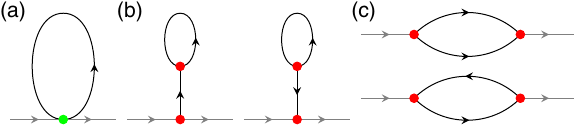
FIG. 3. Feynman diagrams contributing to 1 =S many-body corrections in anharmonic spin-wave theory. (a) Hartree diagram with the number-conserving four-magnon vertex indicated by a green circle. (b) Upwards and downwards tadpole diagrams, with the three-magnon vertices indicated by red circles. (c) Forward (top) and circle (bottom) bubble diagrams. At zero temperature, only the forward bubble diagram is contributing to the